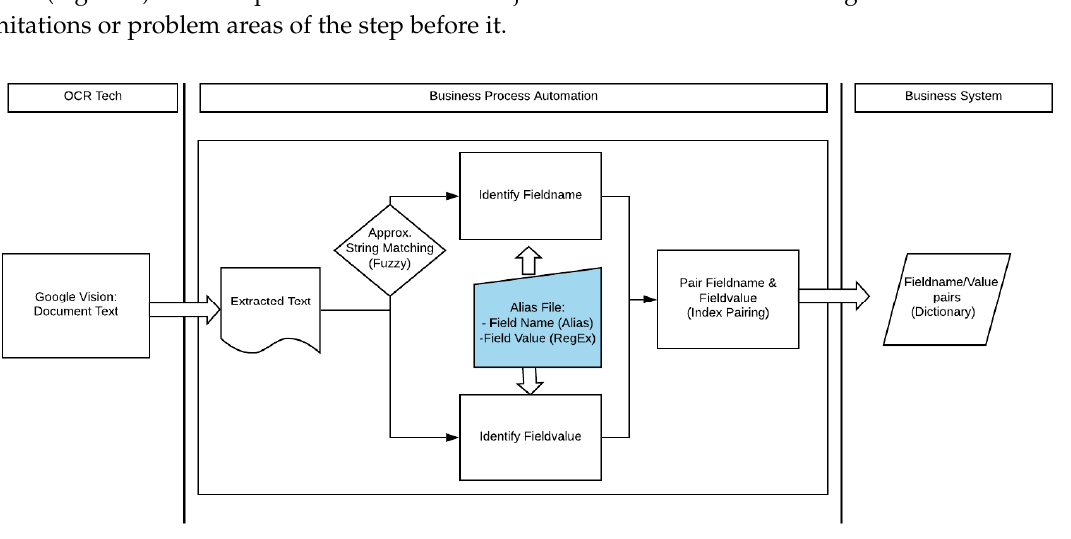
Figure 1. Full image digitization workflow process.